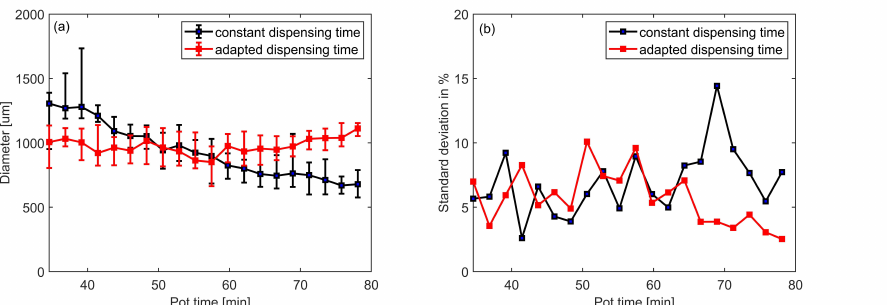
Figure 9. ( a ): Dot diameters over time for constant vs. adapted dispensing time scheme (error bars represent min/max values). ( b ): Standard deviation of dot diameter over time for constant and adapted dispensing scheme.